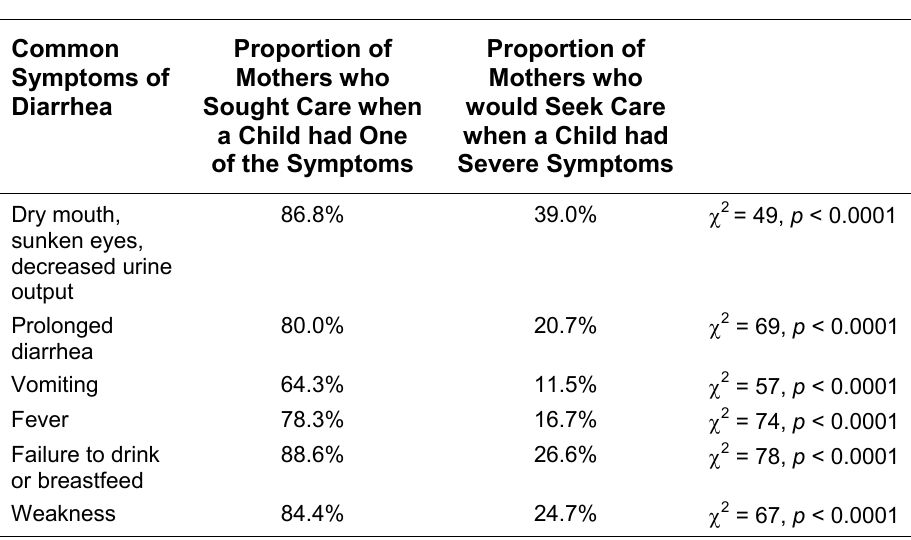
Perceptions on Seriousness of Diarrhea and Care-Seeking